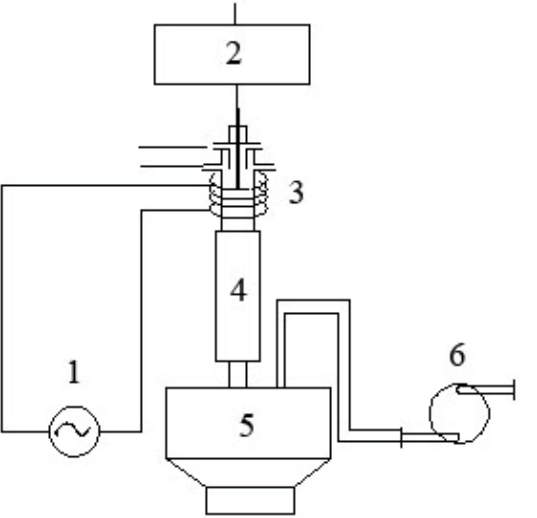
Figure 9. Layout of the RF thermal plasma processing system: (1) plasma power supply system, (2) entrained-flow powder feeder, (3) plasma torch, (4) cylindrical reactor and cooling chamber, (5) powder collector, (6) vacuum pump and exhaust system [90].